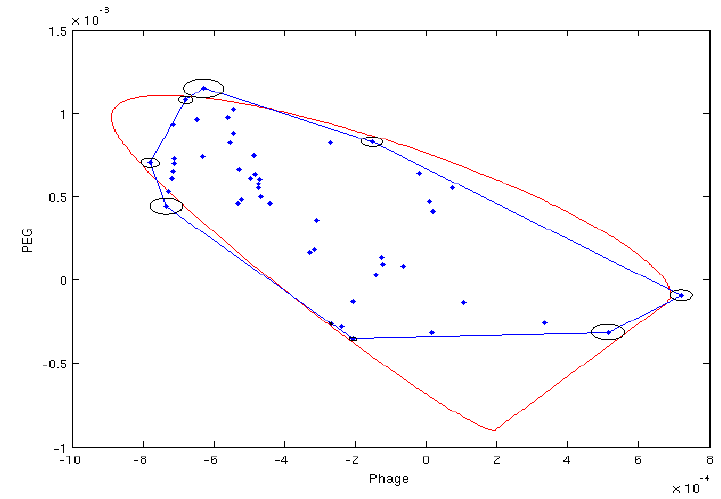
Figure 15. Results of 2D-RDC analysis based on unassigned data from Pf2048.1 obtained in phage and PEG alignment media. The blue lines indicate the convex hull of the 2-D RDC data set determined from the experimental data and the red line indicates the convex hull of the distribution of 2D-RDC data points for the order tensor